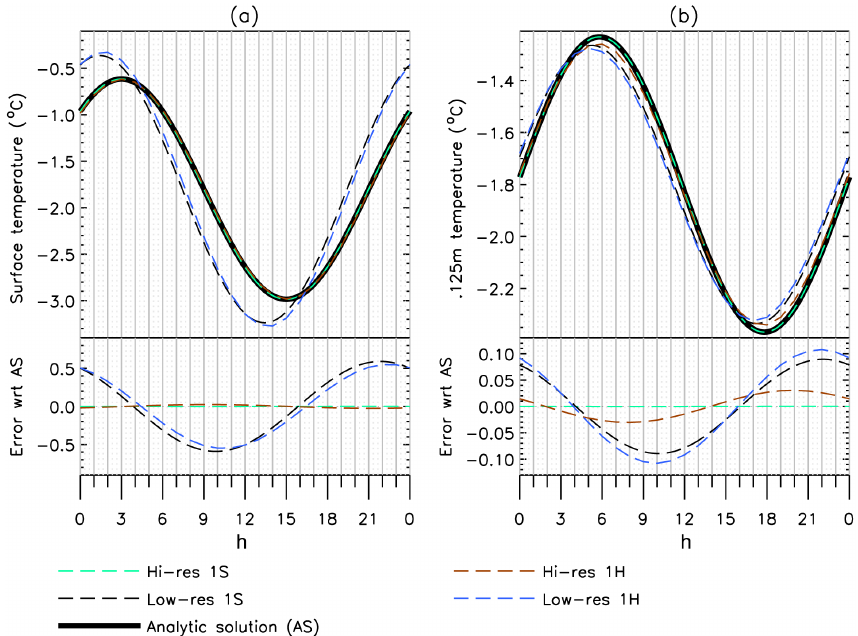
Figure 2. The performance of the CICE temperature solver under varying spatial resolution and time step length, with coupling period 1h. Showing (a) surface temperature; (b) temperature at 0.125m depth.